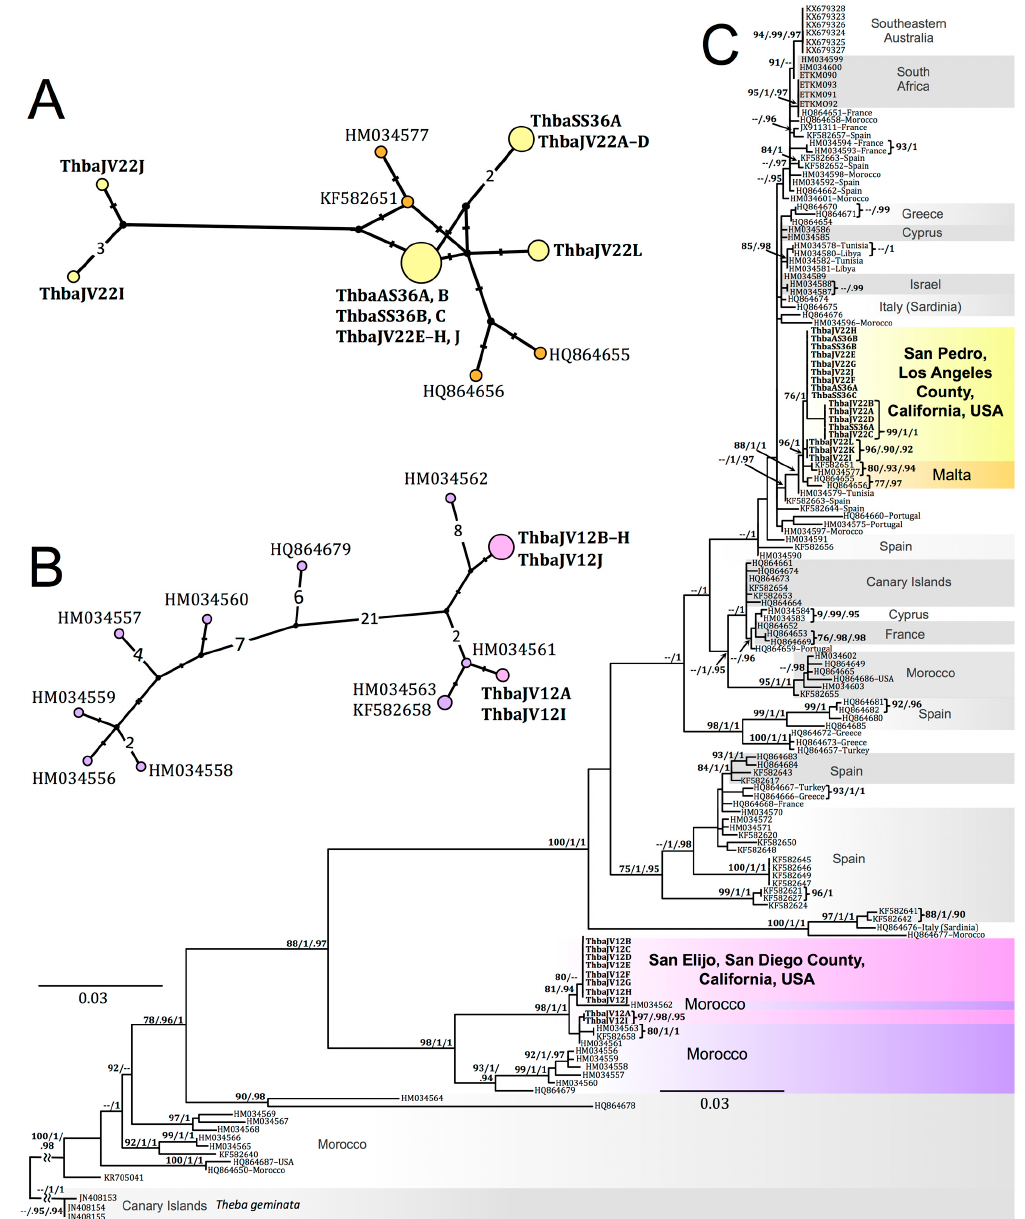
Figure 8. Haplotype networks and RAxML maximum likelihood phylogeny of Theba pisana mtDNA CO1 haplotypes (655 bp) from specimens collected in San Pedro, Los Angeles County and San Elijo Lagoon Ecological Reserve, San Diego County, California and available CO1 barcodes of T. pisana were native and introduced. ( A ) Median-joining network of 17 T. pisana CO1 haplotypes from specimens collected in San Pedro, Los Angeles County, California (in yellow) and 4 T. pisana CO1 haplotypes from Malta (in orange) [1,39,40]. ( B ) Median-joining network of 10 T. pisana CO1 haplotypes from specimens collected in San Elijo Lagoon Ecological Reserve, San Diego County, California (in pink) and 10 T. pisana CO1 haplotypes from Morocco (in purple) [1,39,40]. In both haplotype networks, circle size is proportional to the number of shared haplotypes in the dataset, and each hashmark represents a single nucleotide difference between haplotypes. ( C ) RAxML phylogeny based on partial CO1 sequence data (655 bp) from specimens collected in San Pedro, Los Angeles County and San Elijo Lagoon Ecological Reserve, San Diego County, with the outgroup Theba geminata , GenBank acc. no. JN408154, from Lanzarote, Canary Islands, Spain [39]. Color coding is consistent with haplotype networks. RA × ML bootstrap support values ≥ 75 are followed by Bayesian posterior probabilities ≥ 0.90 and Bayesian posterior probabilities for the dataset analyzed without the third codon position. Specimen names and locations in bold indicate T. pisana specimens collected in Southern California and sequenced for this study; GenBank accession numbers are in Table